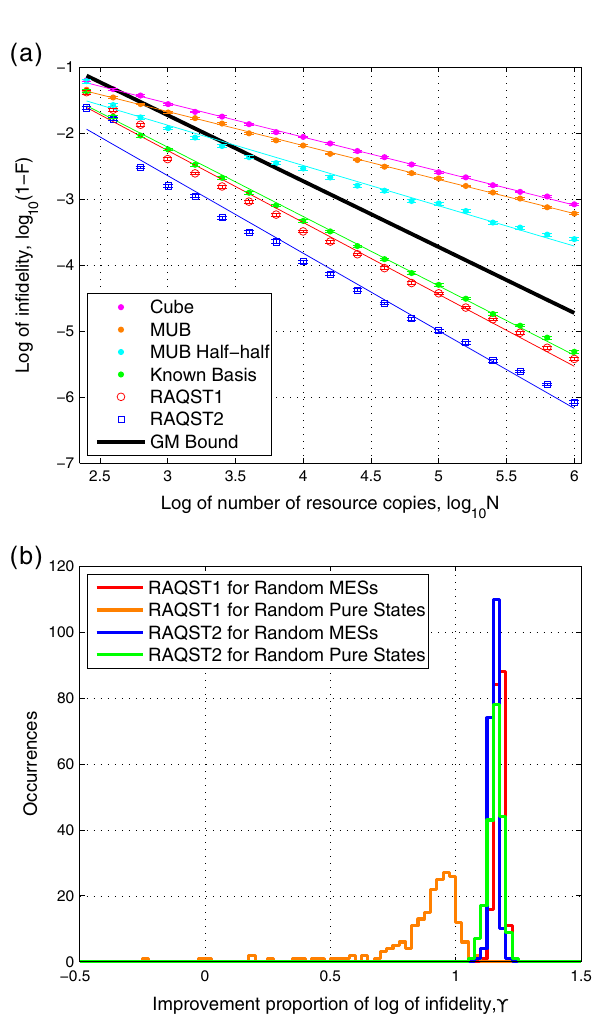
Fig. 1 Performance of the RAQST protocol for pure states. a ffiffiffi p 2 In fi delity vs. N for HV j i (cid:2) VH j i = with different tomography protocols. Each point is averaged over 100 realizations. Error bars are the standard deviation of the average. b Histogram of improvement proportion of in fi delity (a value greater than one means beating the Gill – Massar bound; see text for details.) for 200 randomly selected MESs and 200 pure states when the total number of copies is N = 10 4 for each random state. Each generated state is repeated through the RAQST protocol for 200